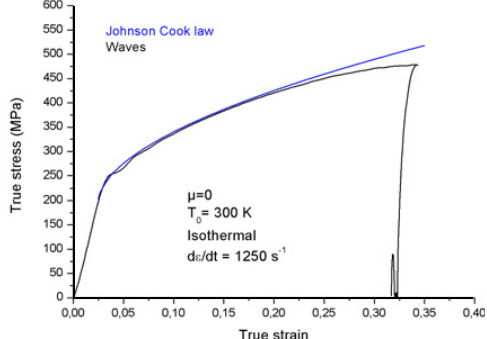
Fig. 4. Comparision between calculated true stress true strain and Johnson Cook law.